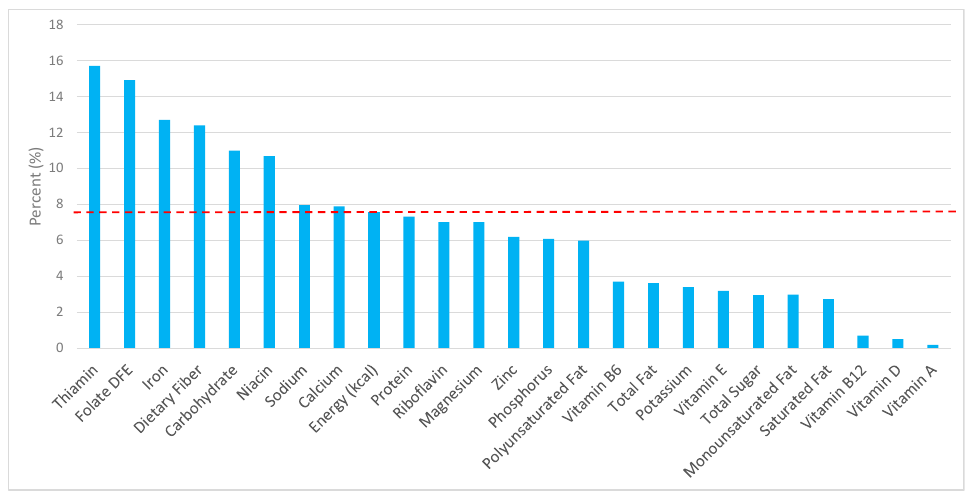
Figure 2. Breads, rolls, and tortillas as sources of energy and nutrients using NHANES 2009–2012, for adult females. Data are for adult females aged ≥ 19 years of age ( n = 5349), Day 1 intakes; dashed red line represents the percentage of energy provided and nutrients that surpass energy (kcal) contribution. Thus, nutrients above the dashed red line show the food category provides a greater percentage in the diet to showcase meaningful nutrient density in the diet per